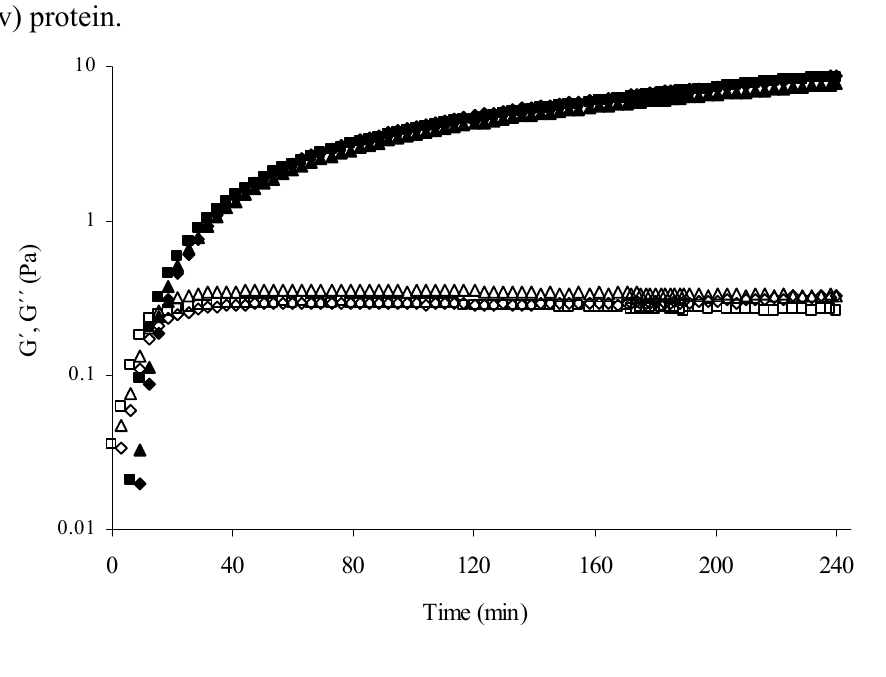
Figure 2. Mechanical spectrum of MBAX (G’  , G’’  ) and MBAX-insulin (G’ ▲ , G’’ ) or MBAX- β -lactoglobulin (G’  , G’’ ) gels at 4 h. Gels at 2.5% (w/v) in MBAX and 0.1% (w/v) protein. Data obtained at 25°C and 5%